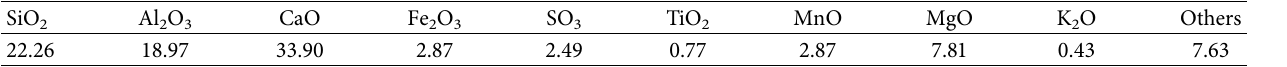
Table 1: The chemical composition of the nickel slag.